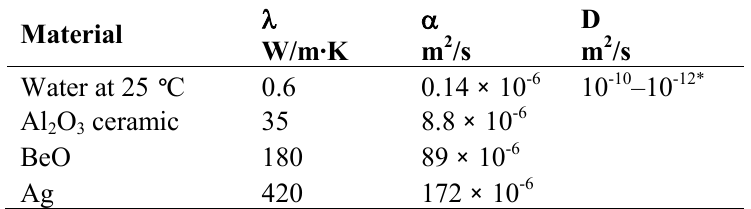
Table 1. Values for thermal conductivity ( λ) , thermal diffusion ( α) and diffusion coefficient for small molecules like